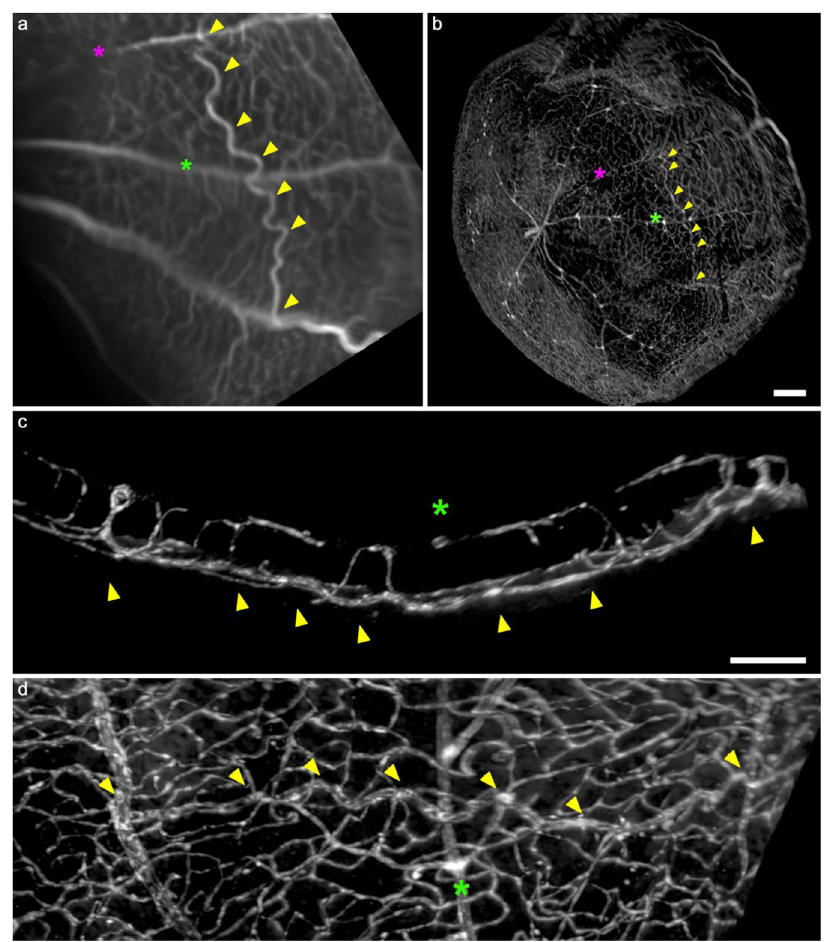
Fig. 5 In vivo imaging and LFSM of an anti-CD31 immunostaining mouse eye after experimental retinal vein occlusion. a in vivo scanning laser ophthalmoscopy of the collateral vessel (arrowheads) running under an artery (green asterisk); the site of the occlusion is shown by the magenta asterisk, clearly visible by the lack of fl uorescein perfusion; the collateral vessel is easily differentiated from other vessels by in-vivo ophthalmoscopy, characterized by a tortuous phenotype. b in toto LFSM of the same eye after anti-CD31 immunolabeling. The collateral vessel can be found using its 3D correspondence to in-vivo imaging. c and d , close-ups showing that the collateral vessel (arrowheads) is located in the deep vascular layer, under the artery (green asterisk) (Scale Bars: a and b: 200 µ m; c and d , 50 µ